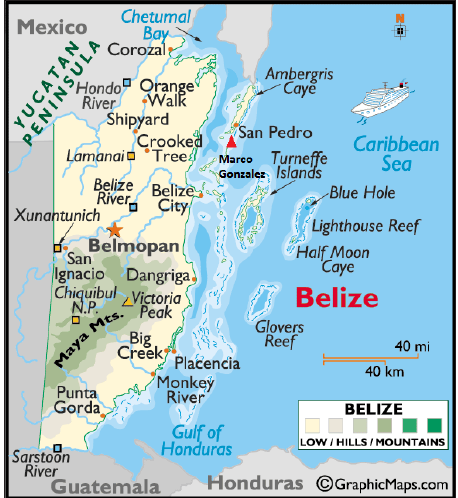
Figure 1: Map of Belize. The site of Marco Gonzalez is located at the south end of the island of Ambergris Caye, ca. 6 km south of San Pedro Town (Reproduced with permission of